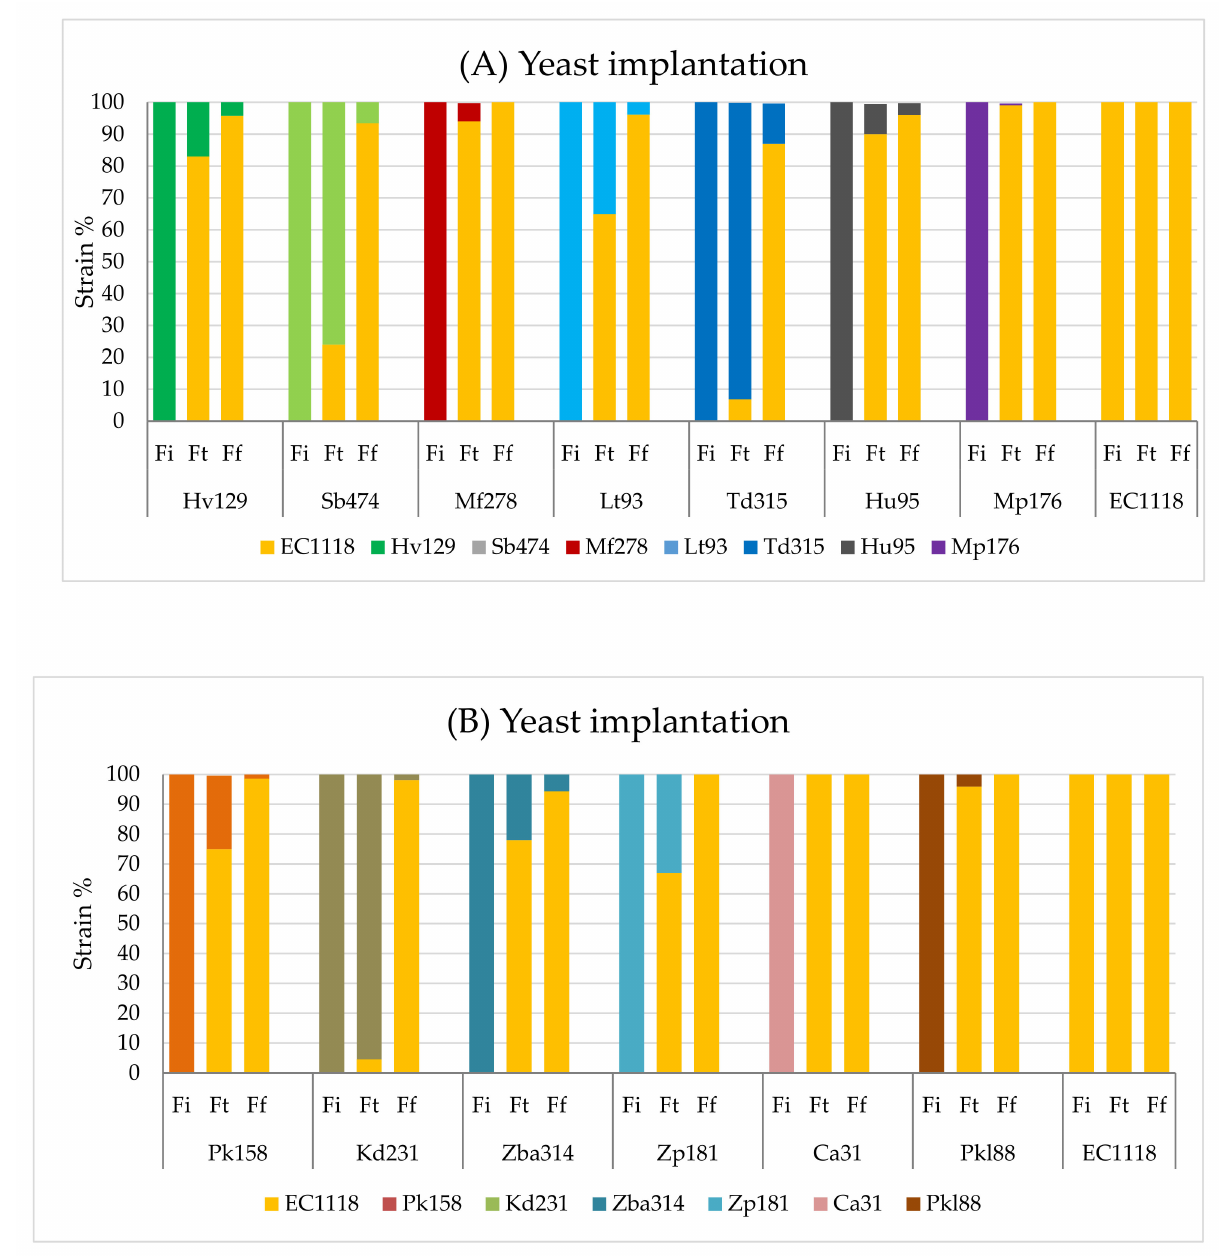
Figure 2. The implantation ability of different non- Saccharomyces yeast species at the initial (Fi), middle (Ft), and final stages (Ff) of sequential fermentations of ( A ) Hv129, Sb474, Mf278, Lt93, Td315, Hu95, and Mp176; ( B ) Pk158, Kd231, Zba314, Zp181, Ca31, and Pkl88; and the control